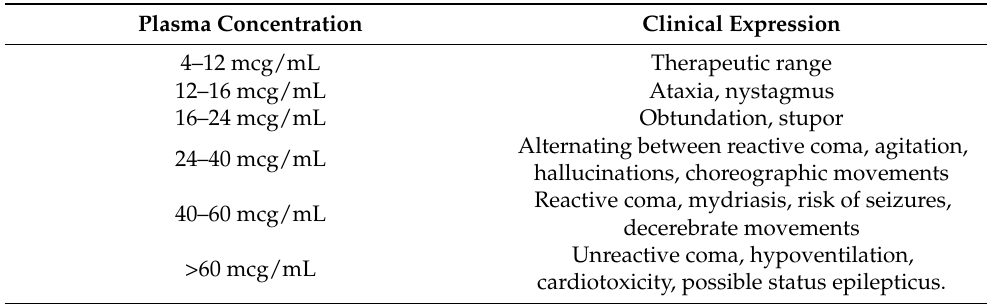
Table 1. Correlation between plasma concentrations of carbamazepine and clinical